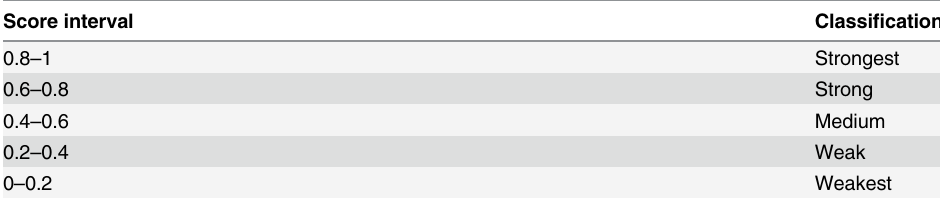
Table 4. A grading standard of